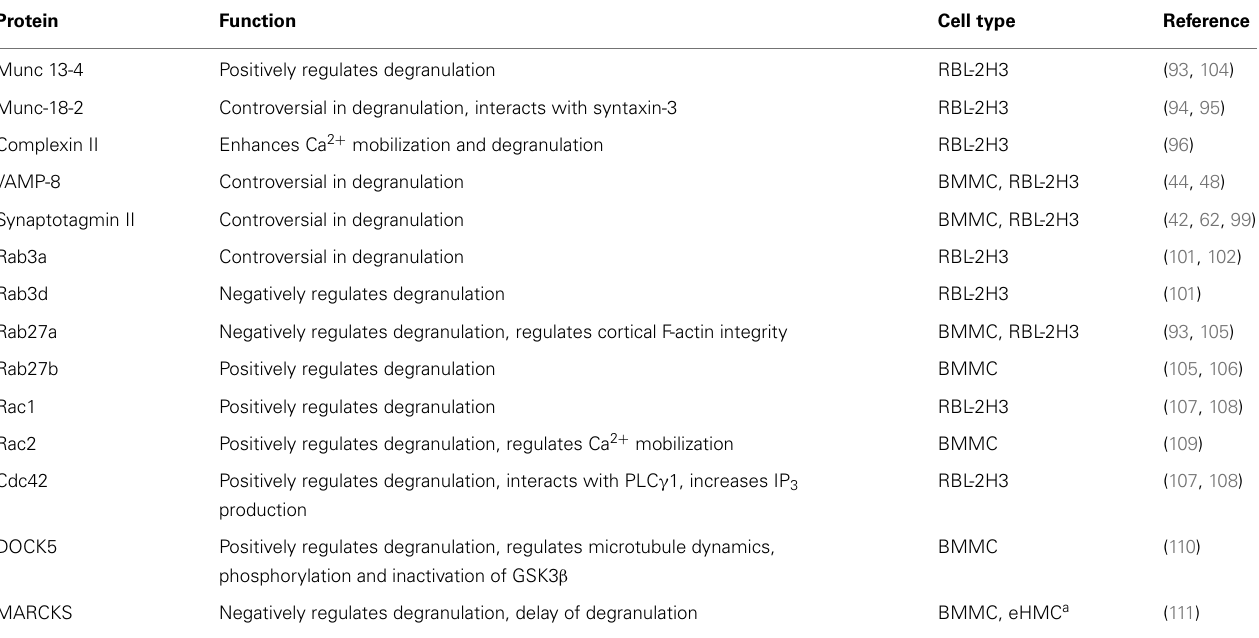
Table 5 | Molecules involved in mast cell degranulation